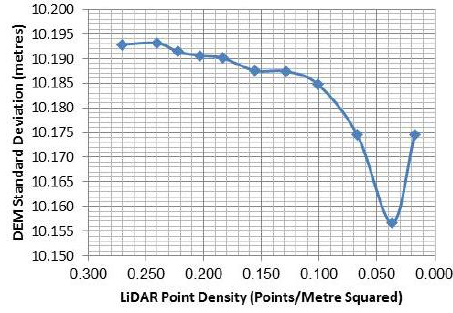
Figure 20. The effects of reductions in LiDAR data on the standard deviation of the DEM